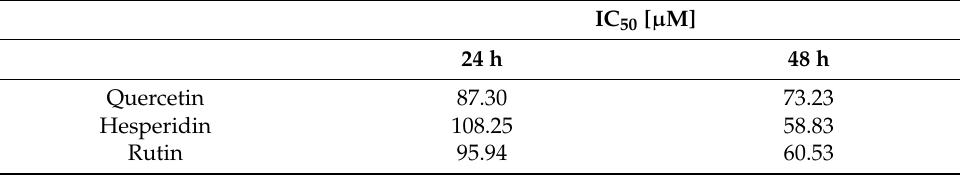
Table 1. The IC 50 values of selected polyphenols relative to the Detroit 562 cell